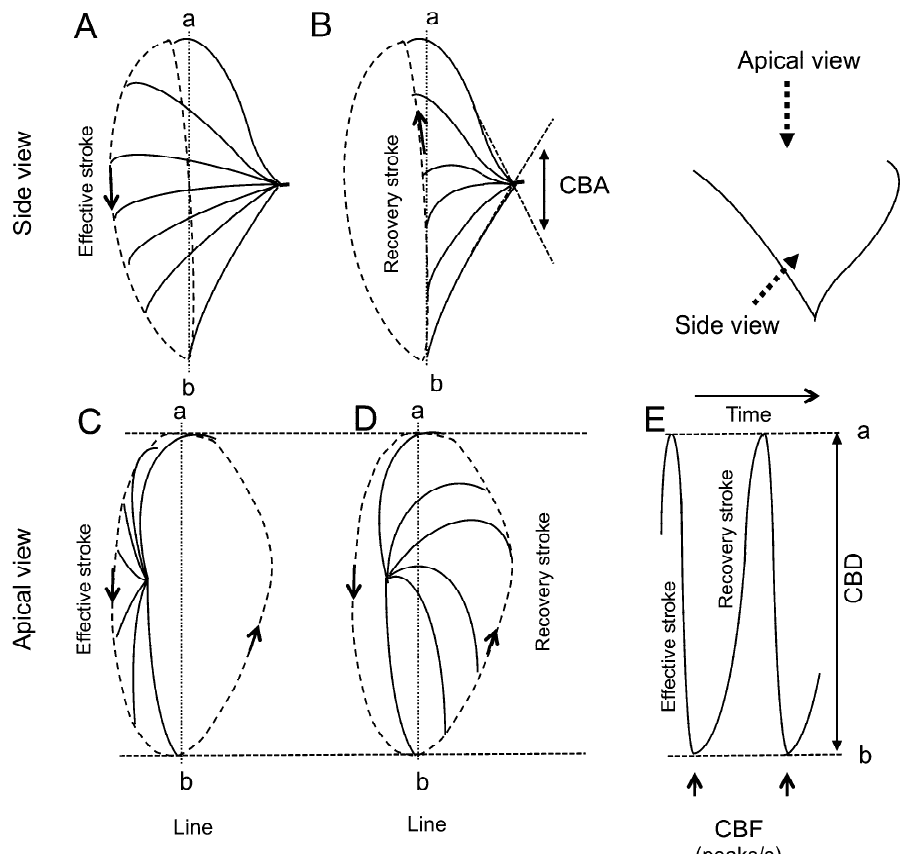
Figure 2. Schematic diagram of ciliary beating. The cilium travels in different planes during the effective and recovery strokes. During the effective stroke, the cilium tip moves in an arc with maximum speed in the plane perpendicular to the cell surface, and then, in the recovery stroke, the cilium swings back close to the cell surface. ( A , B ) Side view. Panels A and B show the effective stroke and the recovery stroke, respectively. The angle between the start and the end of the effective stroke is the ciliary beat angle (CBA, an index of ciliary beat amplitude). ( C , D ) Apical view. Panels C and D show the effective stroke and the recovery stroke, respectively. ( E ) The time course of changes in the light intensity of line a–b. To assess the amplitude of ciliary beating in the apical view, the distance between the start and the end of the effective stroke was measured. The measured distance is the ciliary beat distance (CBD, another index of ciliary beat amplitude). CBF, ciliary beat frequency.